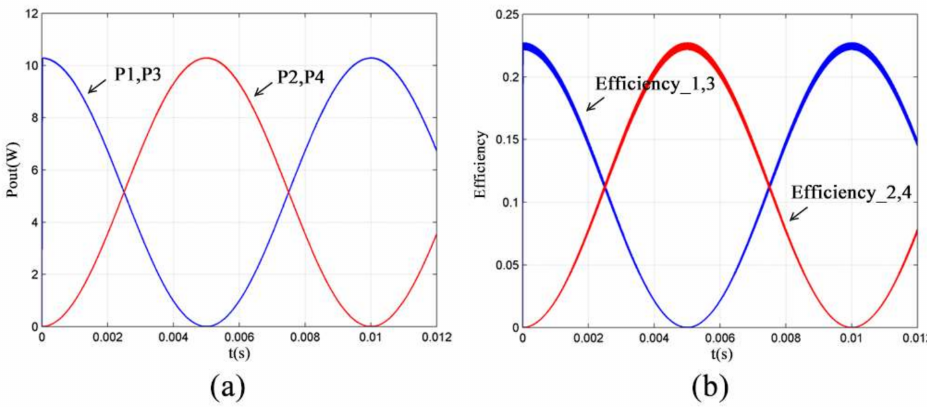
Figure 10. Waveforms of the output power and transfer efficiency against time in the four-receiver system: ( a ) output power; ( b ) transfer efficiency.